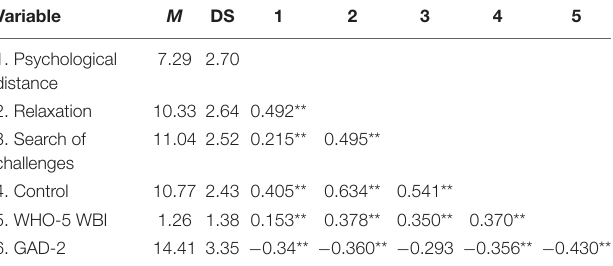
TABLE 3 | Means, standard deviations, and correlations between the Recovery experiences questionnaire (CER), Generalized Anxiety Disorder (GAD-2), and World Health Organization Well-Being Index (WHO-5)